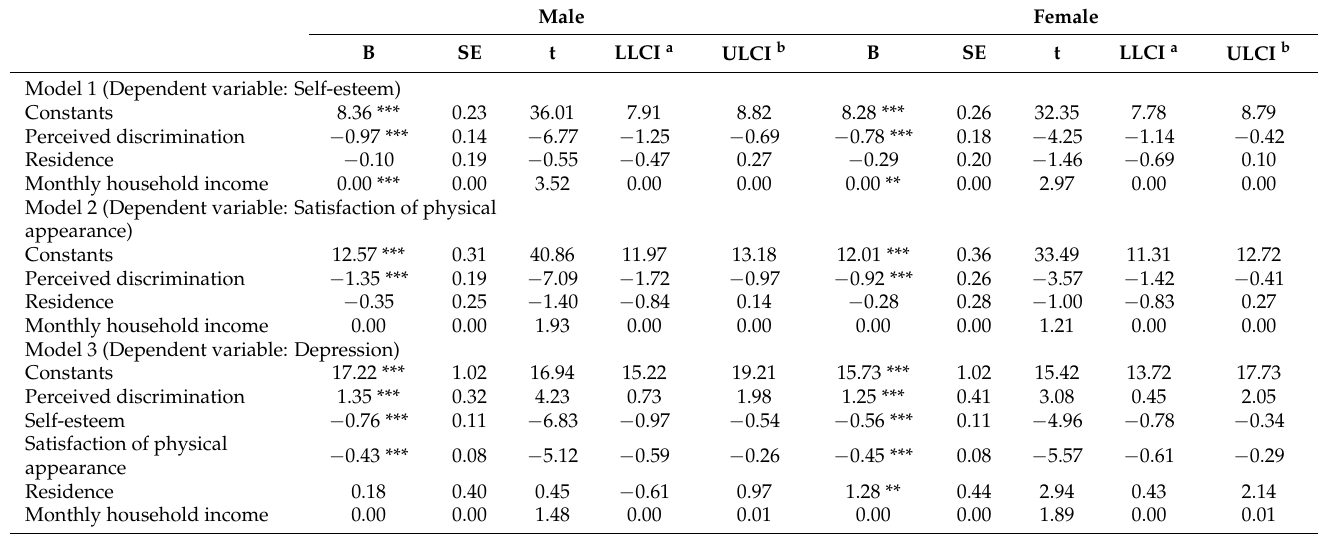
Figure 1. Mediation effects of self-esteem and satisfaction of physical appearance. * p < 0.05, ** p < 0.01, *** p < 0.001. T = Total e ff ect, D = Direct e ff ect, I = Indirect e ff ect. Table 5. Process macro results by